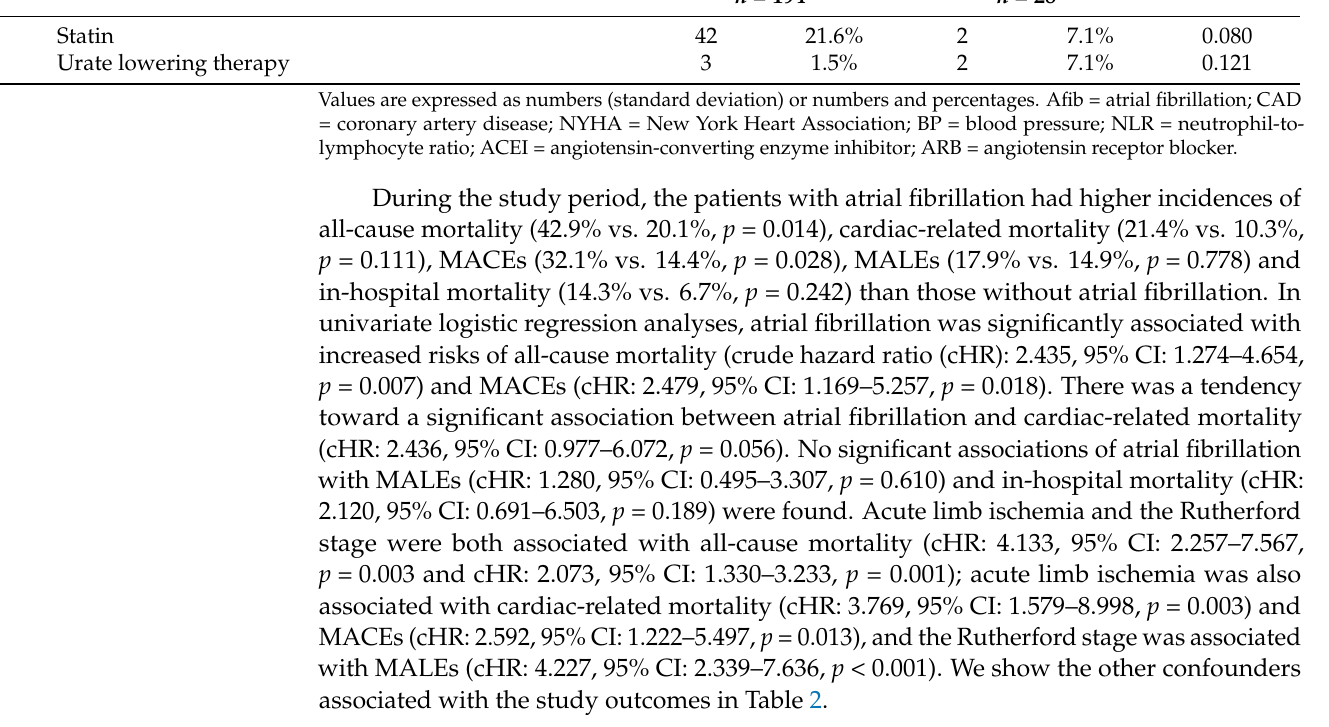
Table 2. Variables associated with study outcomes in patients with critical limb ischemia in logistic regression